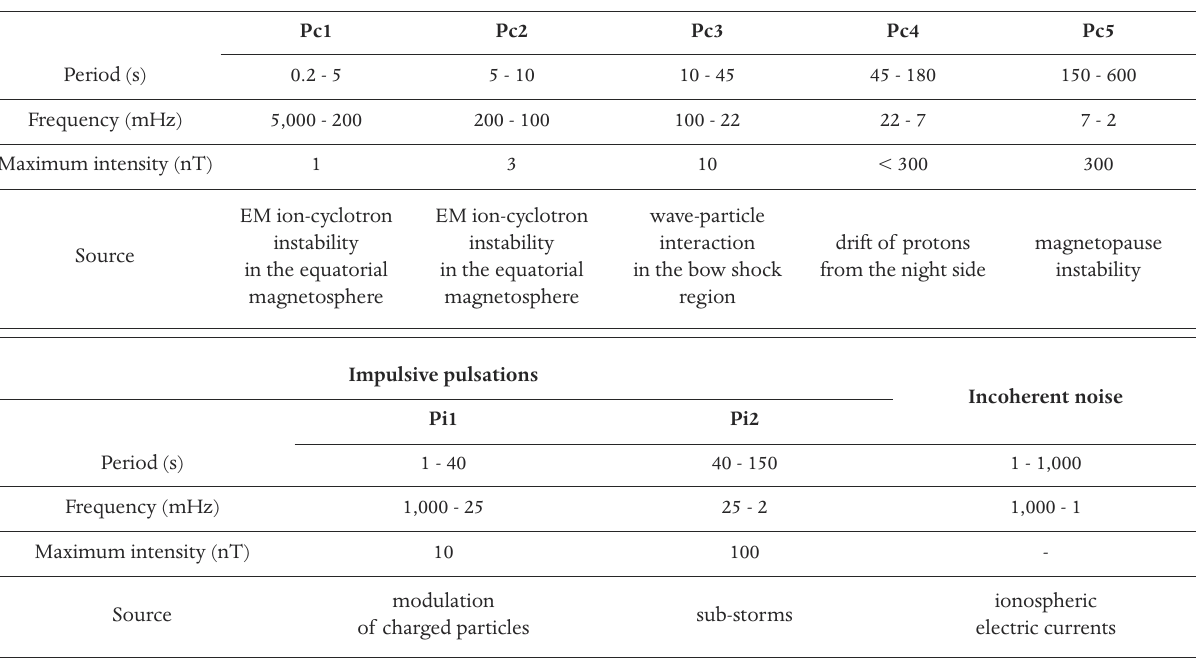
Table 2. IAGA classification and standard nomenclature of the most relevant continuous and impulsive pulsations in the ULF